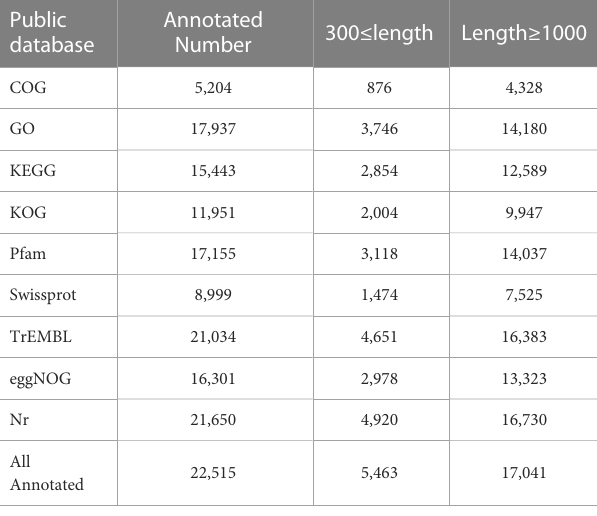
TABLE 2 Summary statistics of functional annotation of Tegillarca granosa unigenes in public databases.